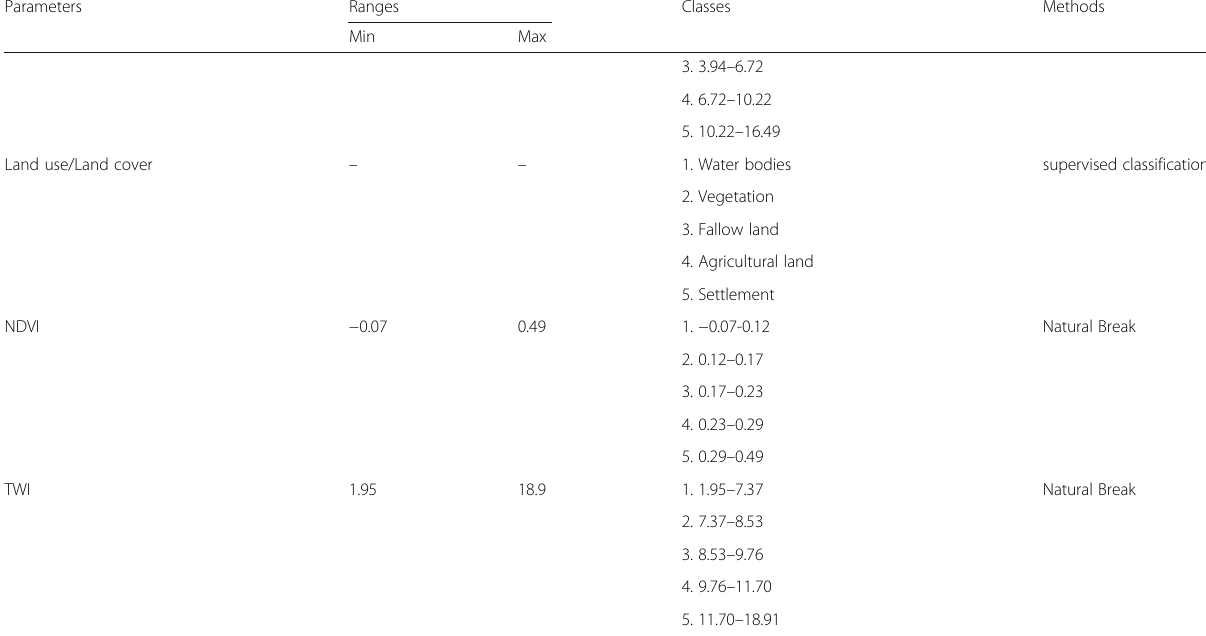
Table 2 Overview of selected parameters used for landslide susceptibility mapping (Continued) Parameters